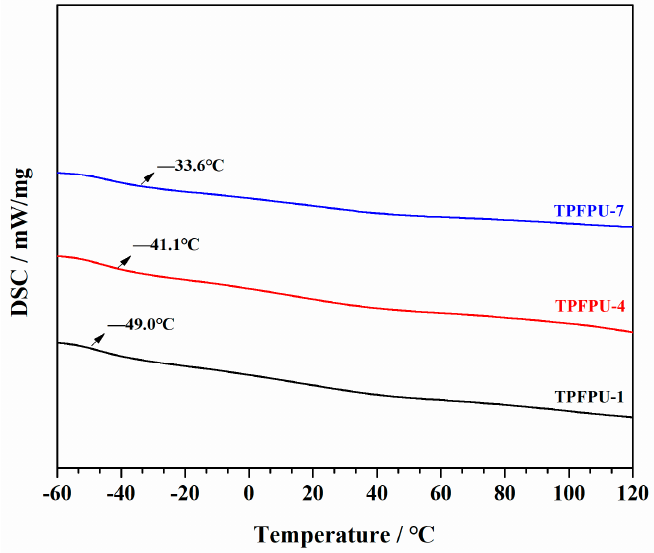
Figure 7. DSC curves of the TPFPUs.